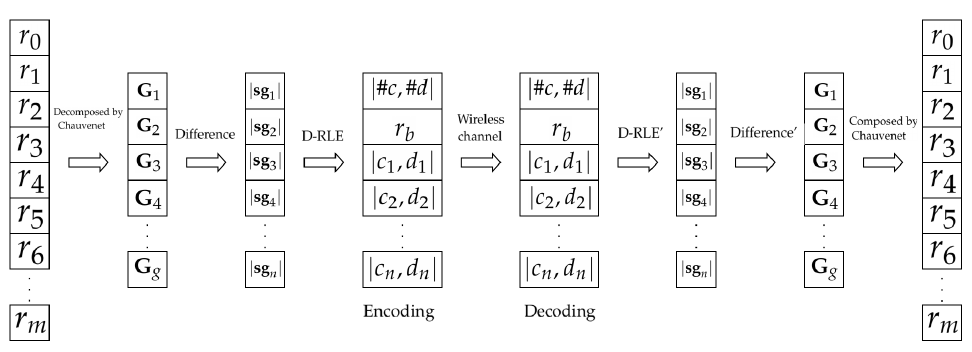
Figure 1. Data encoding and decoding